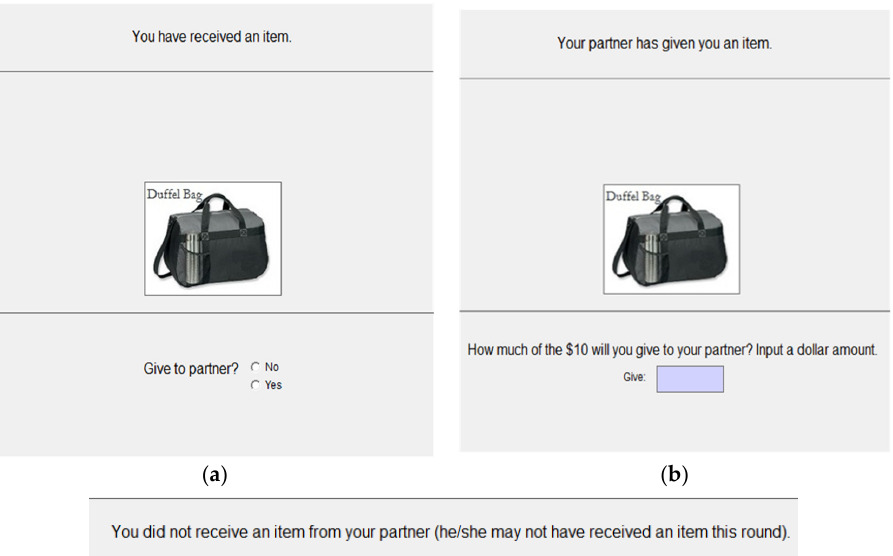
Figure 3. Gift treatment screenshots. ( a ) Gift‐giver’s screen with item; ( b ) Dictator’s screen with item; ( c ) Message to dictator when no gift was given.